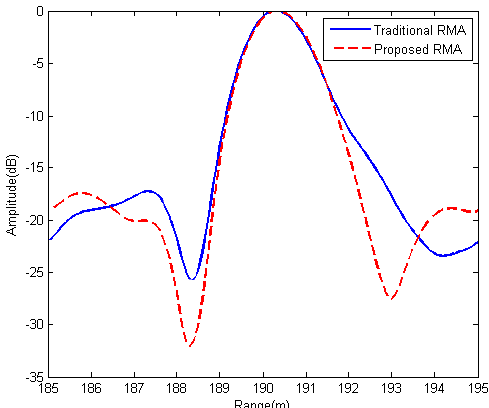
Figure 14. Comparison of the range profiles of an isolated strong point target marked by the red circle in Figure 13a.